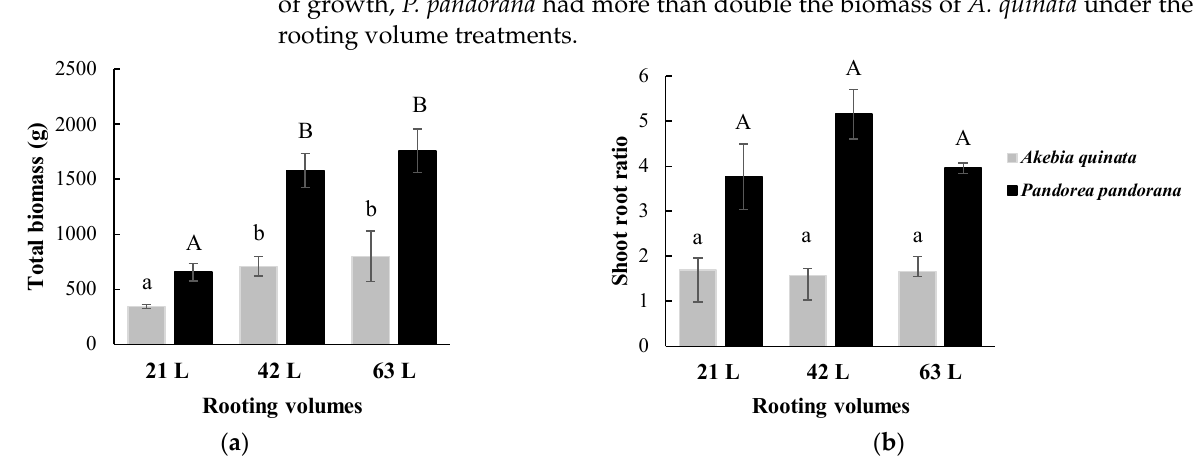
Figure 3. Average total biomass ( a ) and average shoot/root ratio ( b ) of Akebia quinata and Pandorea pandorana plants grown in three different rooting volumes after six months of growth. Values are means ± SE. Different letters represent significant differences within species, p < 0.001; lowercase, Akebia quinata ; capital, Pandorea pandorana .